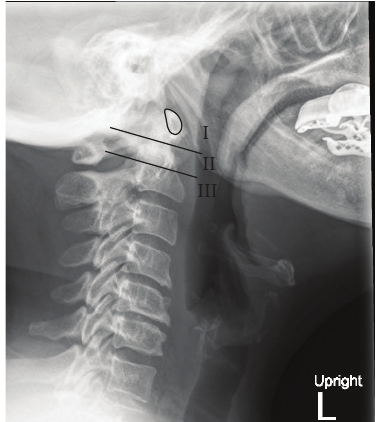
Figure 6: The Redlund-Johnell Criterion is the distance between the inferior margin of C2 vertebral body and a line drawn from the posterior tip of the hard palate (white arrow) to the caudal cortical margin of the occiput (McGregor